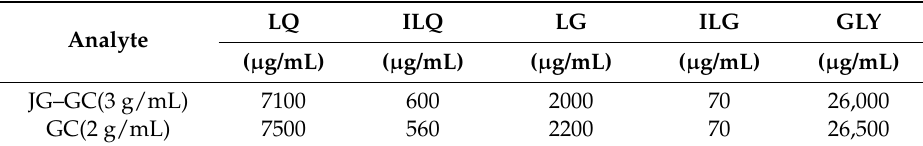
plexus veins at 0.083, 0.167, 0.33, 0.67, 1, 2, 4, 8, 12, 24, 36 and 48 h after drug administration. Table 3. Concentration of the analytes in JG–GC and